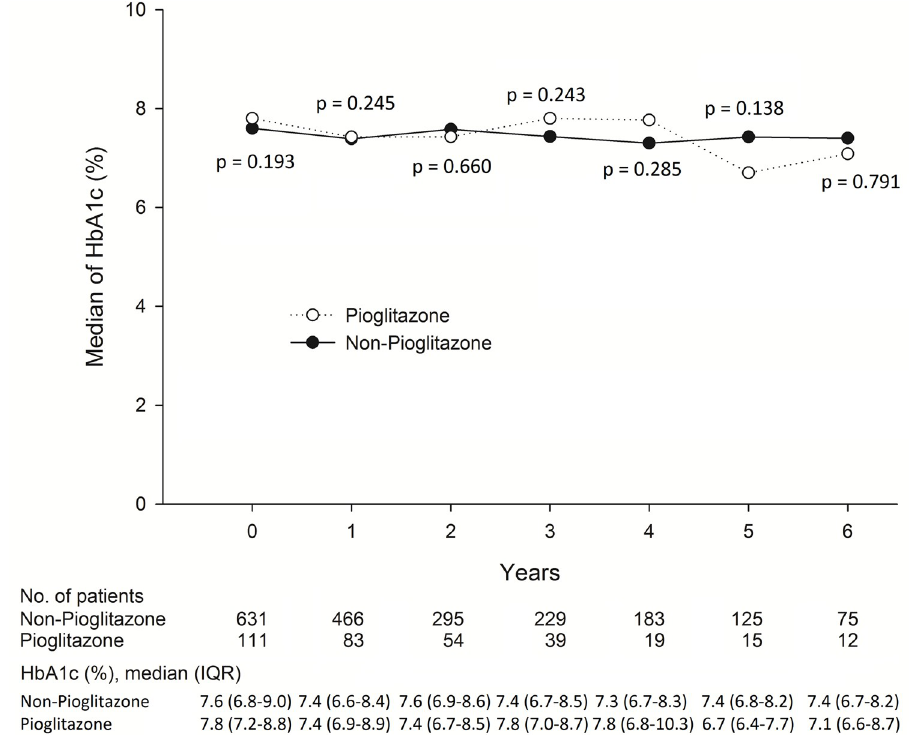
Fig 2. Association between HBA1c between Pioglitazone and non-Pioglitazone users.